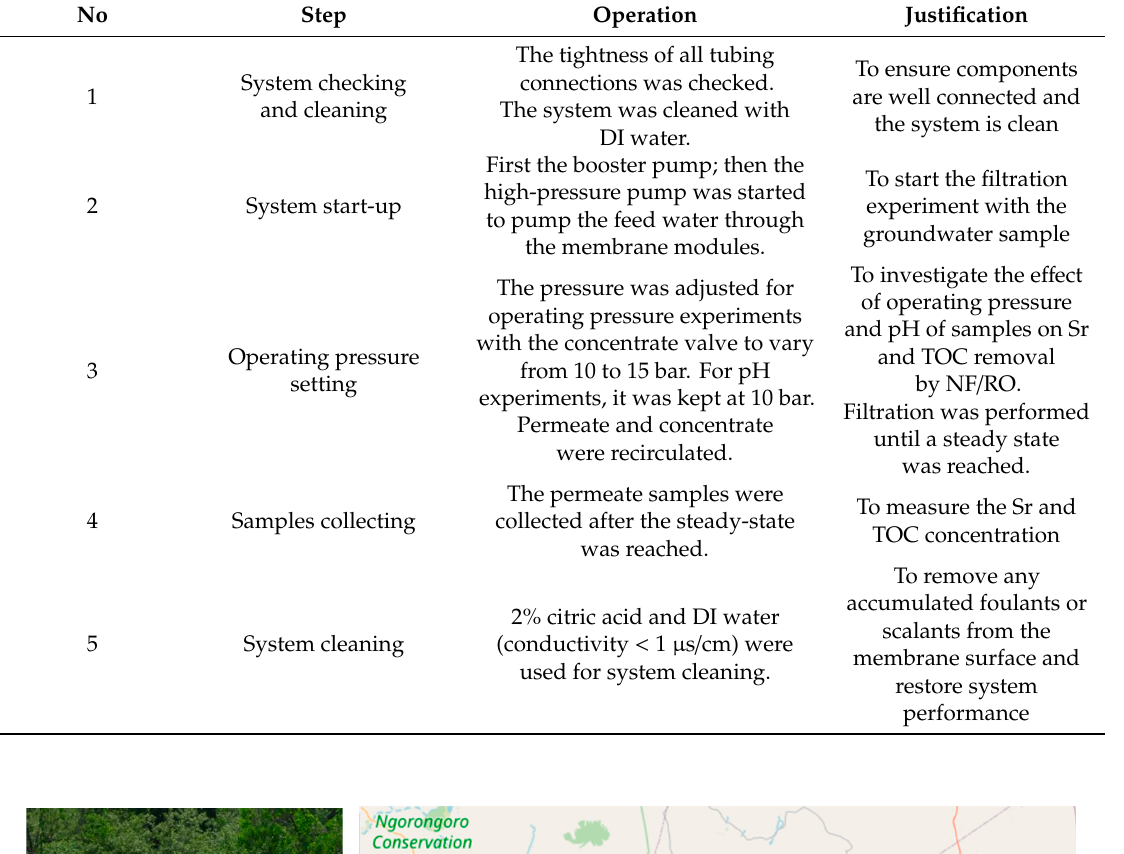
Table 3. The summary of the experimental protocol using pilot-scale GE Osmonics E2-2535TM system.